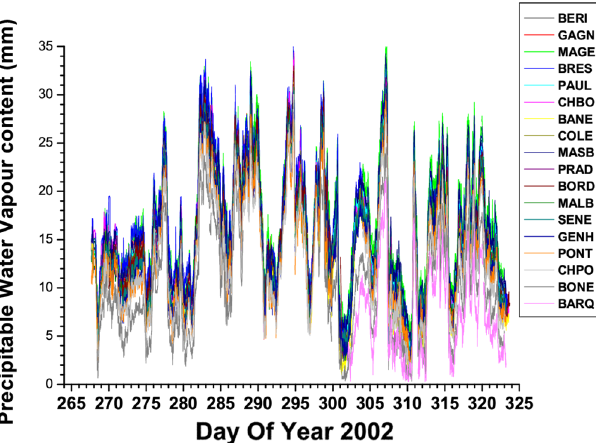
Fig. 13. PWV time series for BORD station from the local network, from 20–22 October 2002 (doy 293 to 295), indicated by the red line. For comparison, domain integrated reflectivity from the me- teorological radar in Bollène is shown in green (in arbitrary units), and accumulated hourly rainfall from the Météo-France rain gauge network is indicated by blue histograms.